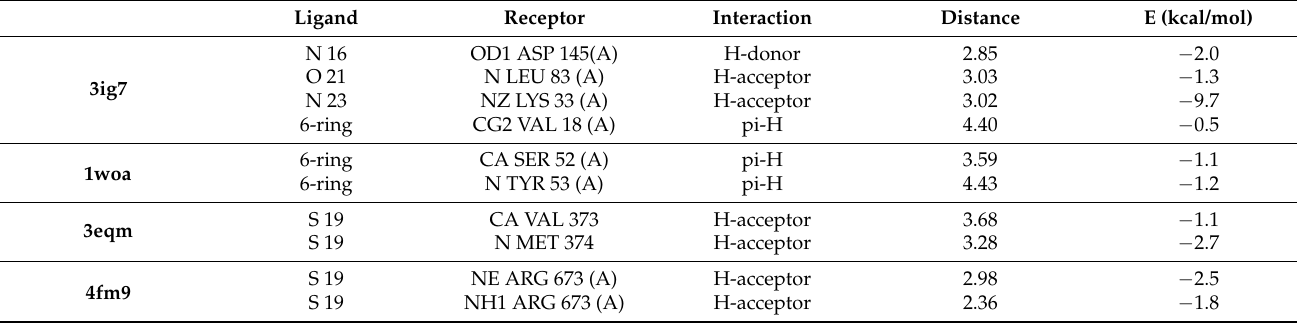
Figure 5. Flow-cytometry plots for HCT 116 staining with Annexin V/7-PI: ( a ) control; ( b ) 3 μ M DOX; ( c ) IC 50 dosage of J. procera methanolic extract. Table 4. Docking interactions and energies of 2 H -1-benzopyran-3-carbothiamide with the receptors topoisomerase